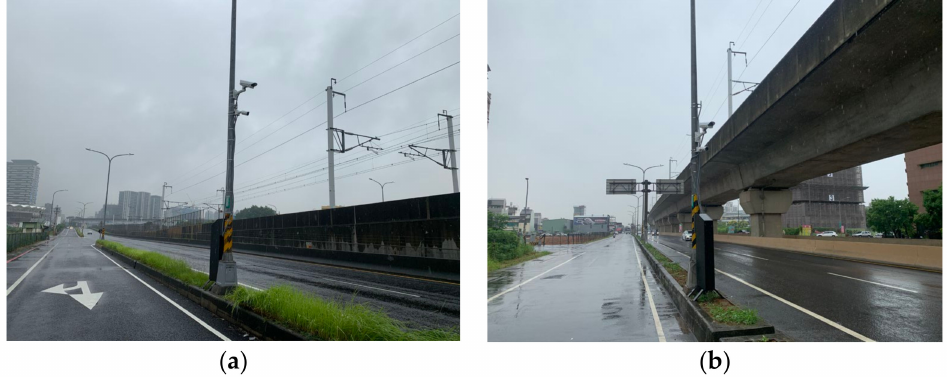
Figure 18. Installation of the LED roadway lighting system: ( a ) Sect. 3 of Gaotie South Road; ( b ) Sect. 5 of Gaotie South